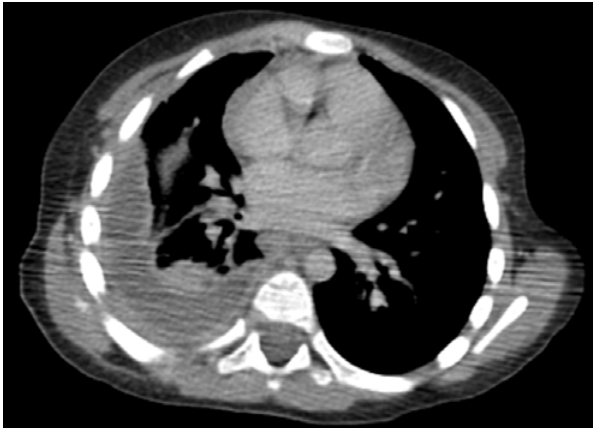
Figure 1: Chest computed tomography revealed the presence of relevant pleural effusion all around the right lung, with paren- chymal lung consolidation and paratracheal, subcranial and hilar